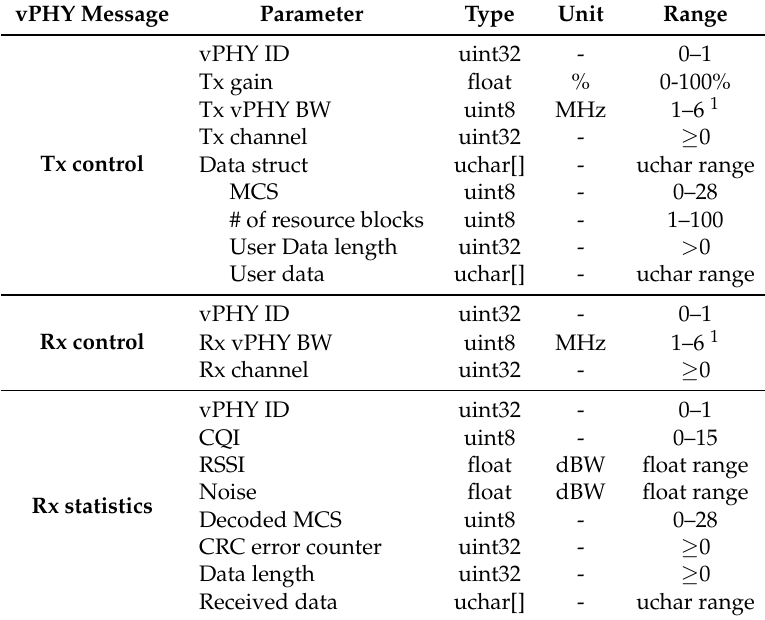
Table 2. List of messages and their respective